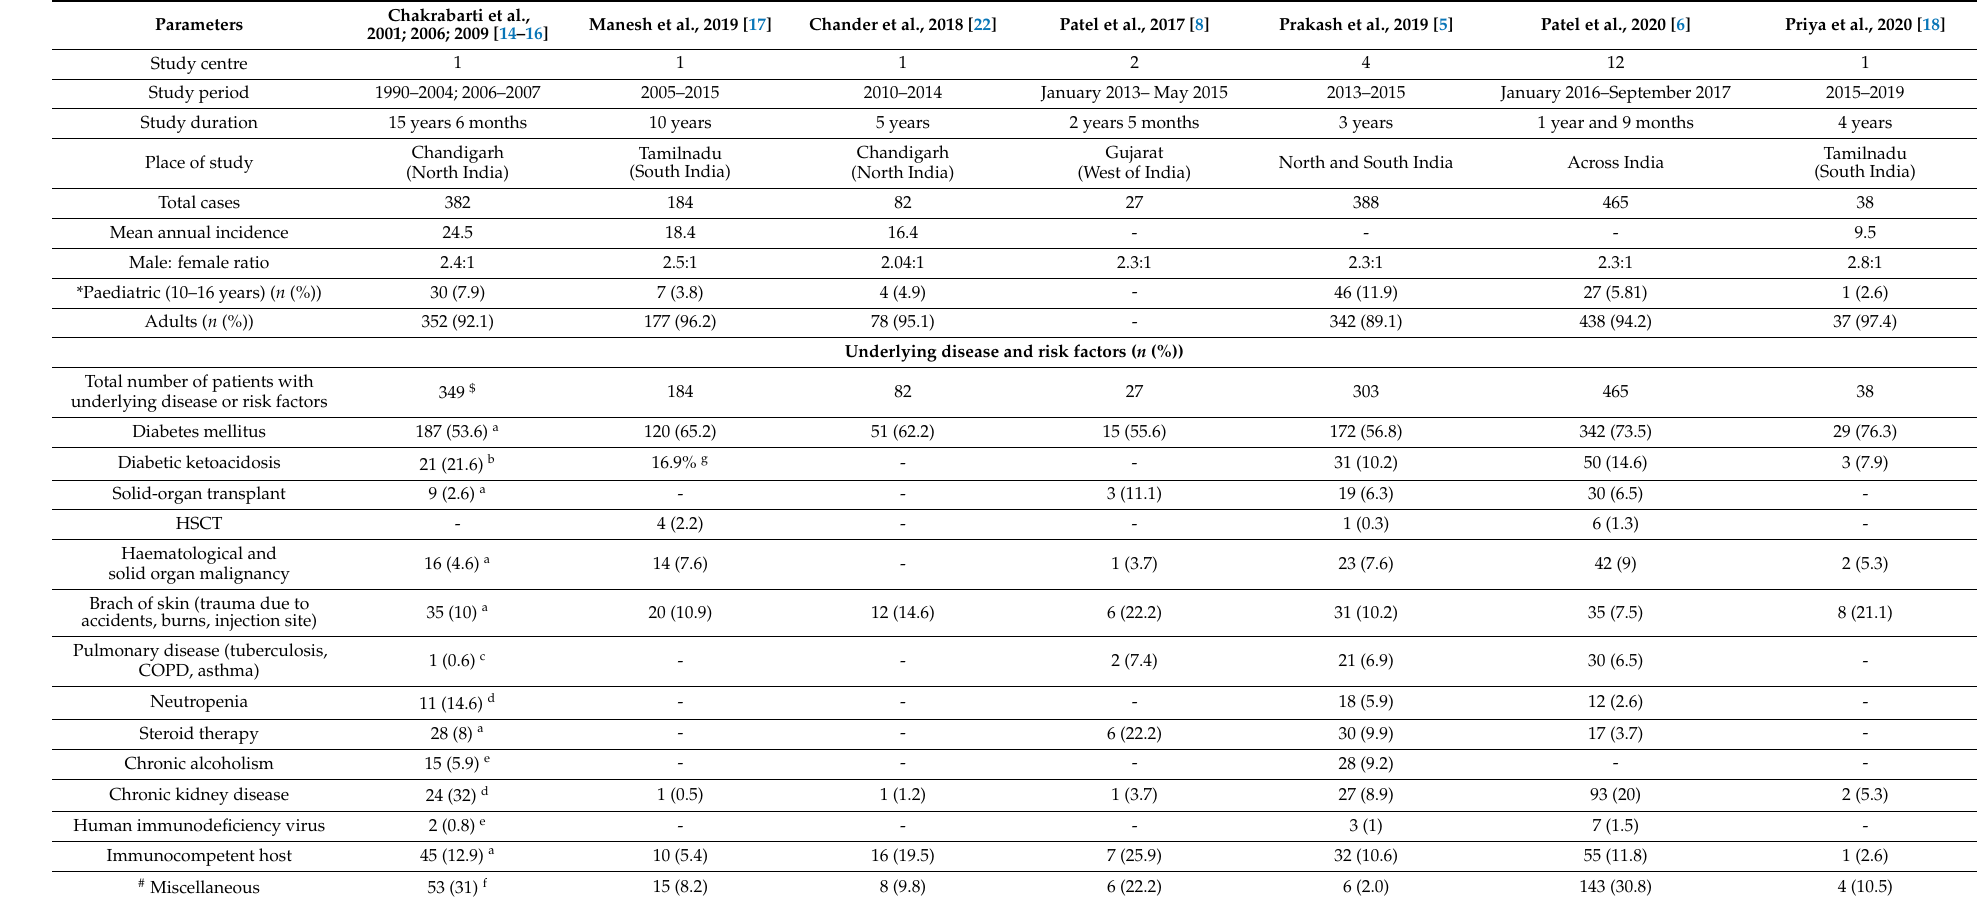
Note: Table values are given in numbers and percentage [ n (%)]. Abbreviations: ROCM, rhino-orbital-cerebral mucormycosis; HSCT, haematopoietic stem cell transplant; COPD, chronic obstructive pulmonary disease. *Paediatric age in different manuscripts are mentioned in range. $ Data were pooled from three case series [14–16]; hence, denominator varies for each underlying illness and risk factor, and denominators are a n = 349; b n = 97; c n = 178; d n = 75; e n = 253; and f n = 171. g Actual number not mentioned in the study [17]. # Miscellaneous risk factors include septicaemia, haematological disorders (aplastic anaemia, megaloblastic anaemia, and pancytopenia), autoimmune disease (scleroderma, systemic lupus erythematosus), liver disease (viral hepatitis), immunodeficiency disorders (common variable